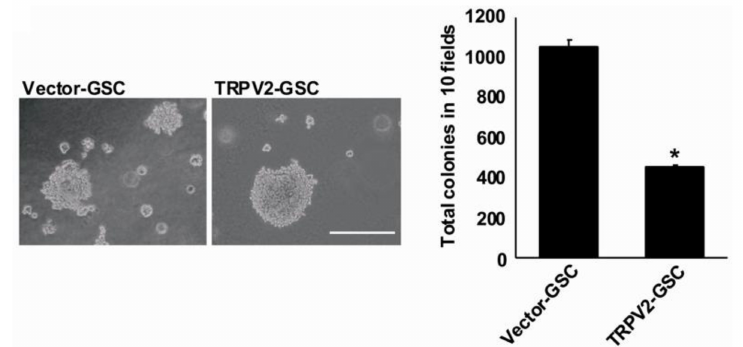
Figure 2. TRPV2 expression reduces glioblastoma stem/progenitor-like cell (GSC) proliferation. Representative phase-contrast photomicrographs show colony formation in vector- and TRPV2-transfected GSCs. The colony number was calculated, taking into account ten random fields. Data shown are representative of one of two separate experiments, * p < 0.01 vs. vector GSCs. Bar: 500 µ m (figure is from